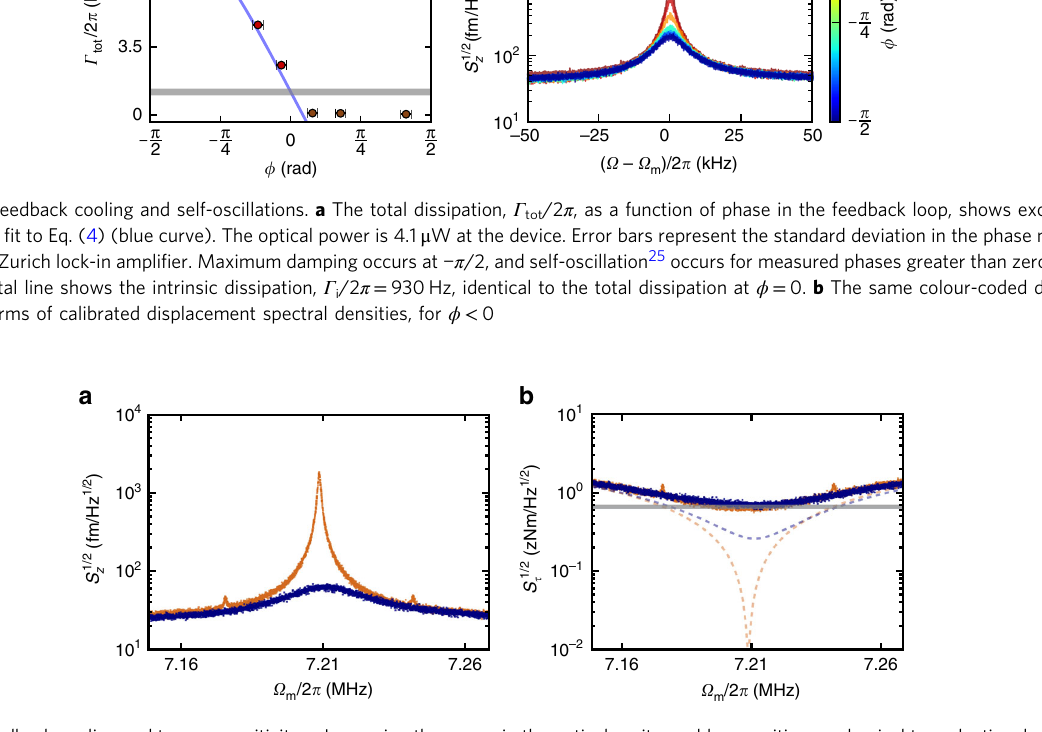
Fig. 4 Optimal feedback cooling and torque sensitivity. a Increasing the power in the optical cavity enables sensitive mechanical transduction, lowering the imprecision noise fl oor to 25 fm Hz − 1/2 (orange trace). The theoretical minimum temperature achievable with this noise fl oor is 8.6 K, and with a feedback phase of − π /2 and a feedback gain of 29 we fi nd we are able to cool to 11.6 K (blue trace). b The calibrated torque sensitivity before (orange) and after (blue) feedback damping to a Q m of just 260. Dashed traces correspond to torque sensitivities in the absence of thermal noise, which is given by the grey line. The device maintains a minimum torque sensitivity of 0.58 zNm Hz − 1/2 , regardless of whether or not feedback is applied. This demonstrates the potential advantage of torque magnetometry with this system, which can maintain state-of-the-art torque sensitivity with short mechanical ring-up